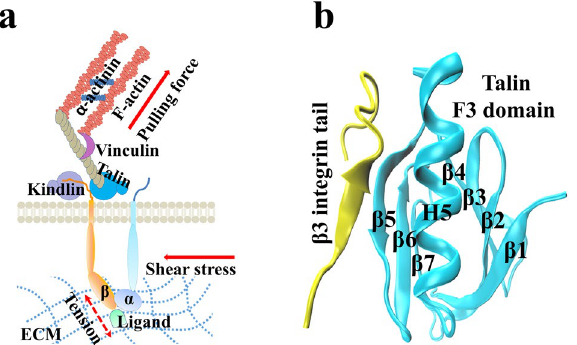
Figure 1. The complex of Talin F3 domain and cytoplasmic distal (CD)-membrane region of β3 integrin in signaling. ( a ) Schematic diagram of transmembrane β3 integrin signaling through Talin under mechanical micro-environment. ( b ) The crystal structure of Talin head F3 domain bound with β3 integrin CD domain. Talin F3 domain consists of two antiparallel β sheets composed of four and three strands, packed into a β sandwich enclosing a hydrophobic core, with a single α helix at the C terminus packing between β5 and β1, partly enclosing one edge of the sandwich. The integrin β3 tail includes a small sheet in the middle and two flexible loops at both